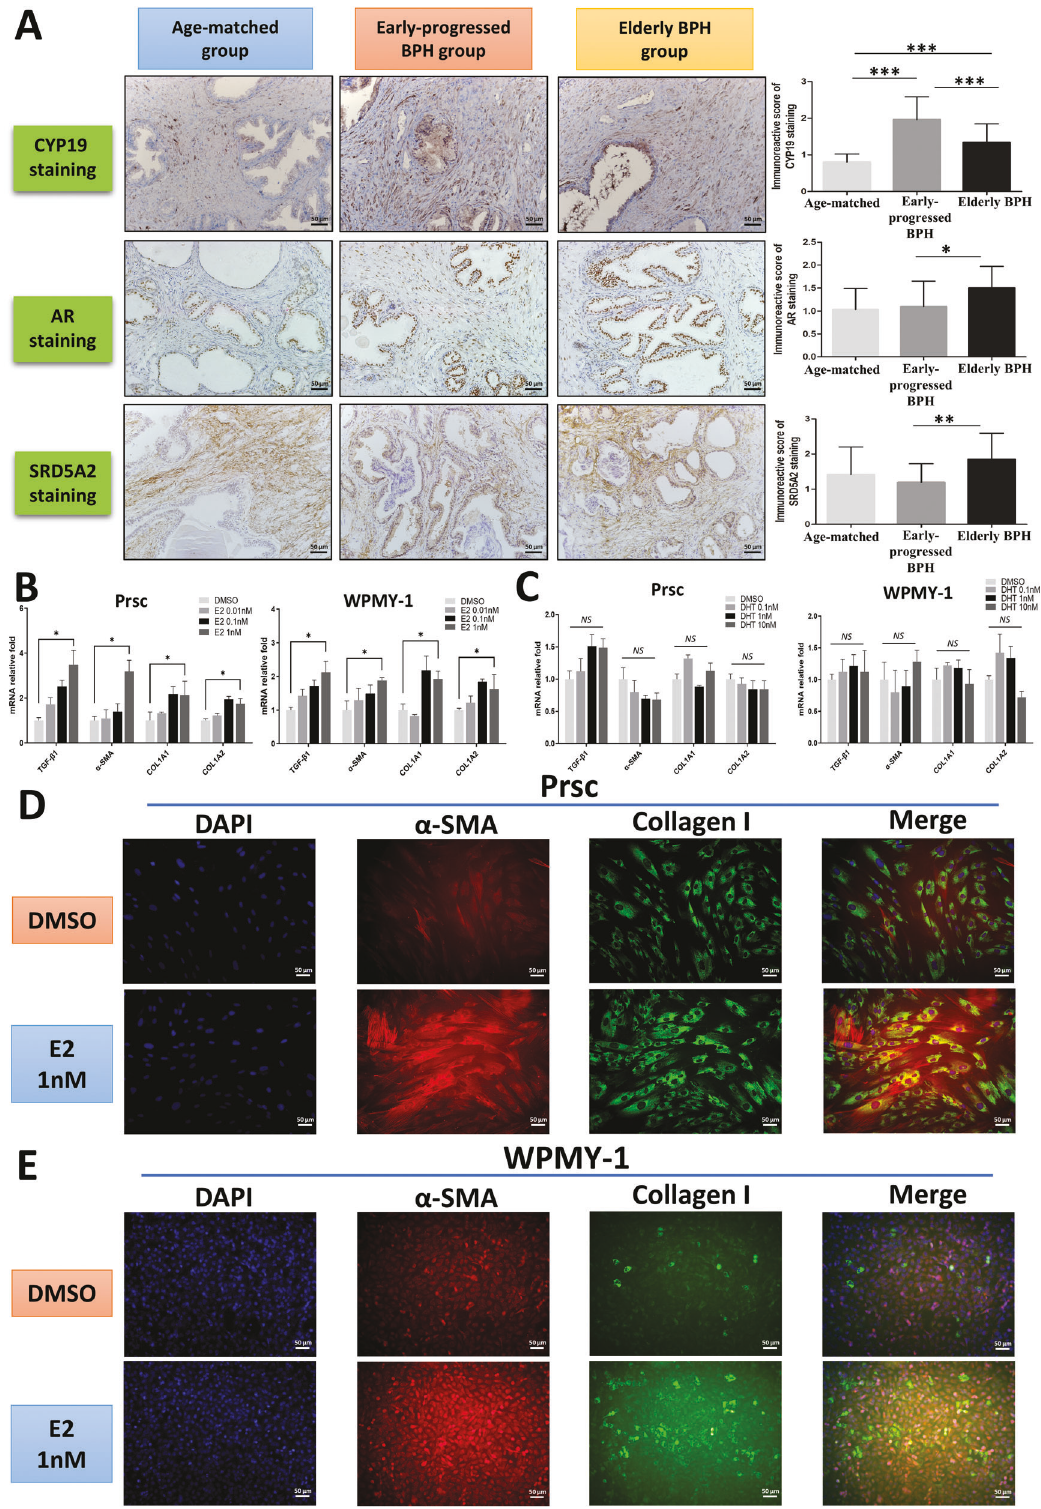
Fig. 2 Increased estrogen promotes prostatic fi brosis in early-progressed BPH patients. A IHC staining for SRD5A2, AR, and CYP19 in the prostatic tissue specimens from the three groups. Scale bar: 50 μ m. Right bar graph is the IOD of positive SRD5A2, AR, and CYP19 staining. The variance was similar between the groups. * P < 0.05, ** P < 0.01, *** P < 0.001. B, C Prsc and WPMY-1 were treated with E2 ( B ) at 0 nM (DMSO), 0.01 nM, 0.1 nM, and 1 nM, or with DHT ( C ) at 0 nM, 0.1 nM, 1 nM, and 10 nM for 48 h. Q-PCR analysis was used to detect the expression of TGF- β 1, α -SMA, COL1A1, and COL1A2. The variance was similar between the groups. * P < 0.05; NS non-signi fi cant. D, E Immuno fl uorescence staining for α -SMA, collagen I, and DAPI in Prsc ( D ) and WPMY-1 ( E ) with or without 1 nM E2 treatment for 72 h. Merged images indicate a myo fi broblastic phenotype. Scale bar: 50 μ